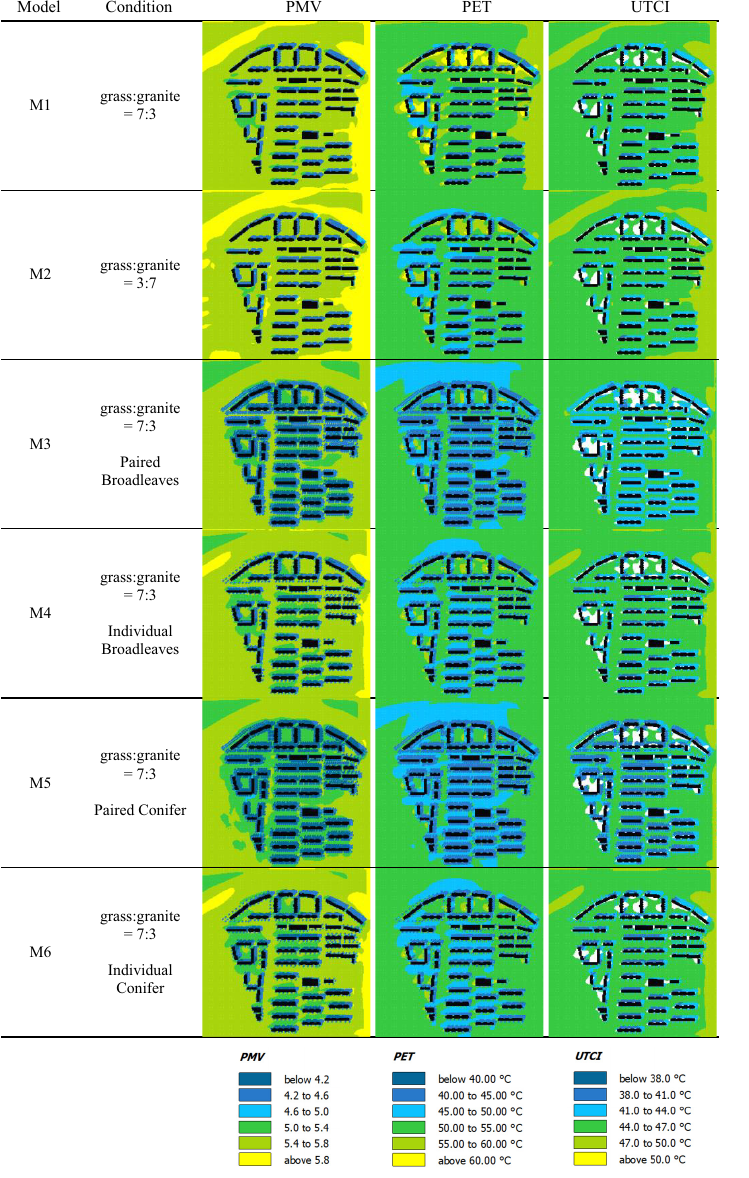
Figure 8. Simulation results of PMV, PET and UTCI under extreme heat